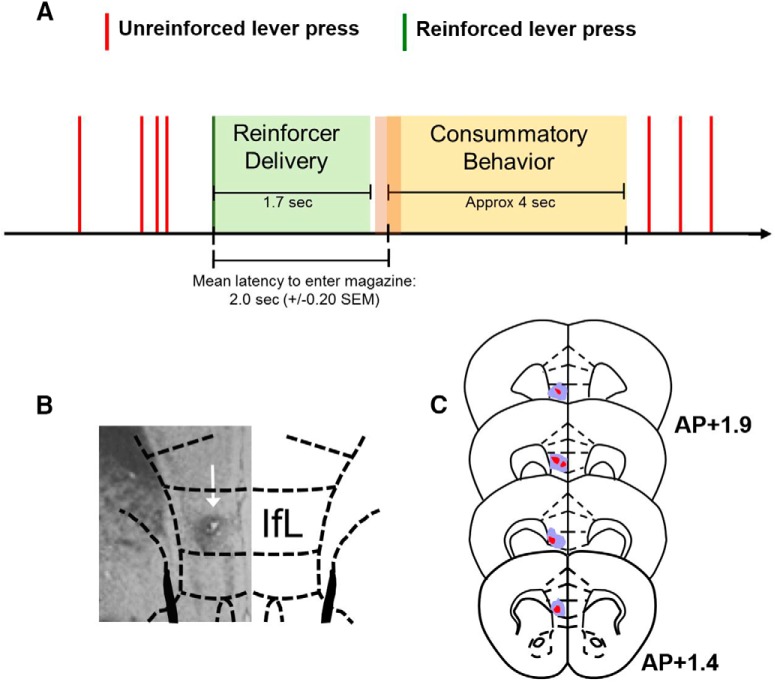
Experimental and recording session time line. A, Illustration of recording session time line. Unreinforced presses (indicated by vertical red lines) were those that did not result in reinforcer delivery. Only isolated unreinforced presses were included in analyses. After reinforced presses (indicated by vertical green line), reinforcer delivery began immediately and lasted 1.7 s. The mean time of consummatory behavior onset was 2.0 s (±0.203 s, SEM) following a reinforced lever press. While the mean time of magazine entry occurred after the termination of the reinforcer delivery epoch, the initiation of consummatory behavior was self-paced and overlap between the reinforcer delivery epochs and consummatory behavior epochs was variable. For analysis of reinforced presses, the pre-press interval consisted of 0.5 s before the initiation of press. The post-press epoch was defined as 0.5 s following the lever press. The reinforcer delivery epoch was defined as the remainder of the “pump on” interval. B, Mice were implanted with multielectrode array probes and, following recovery from surgery, were trained to self-administer sucrose in the RR/RI protocol (Fig. 1). Shown is an example of electrolytic lesions of the recording site. C, Placement of multielectrode arrays within IfL-C for all mice in the study. Blue shaded region represents the maximal size of the lesioned area within each of the anatomic sections shown, while red represents the smallest lesion area within each section.